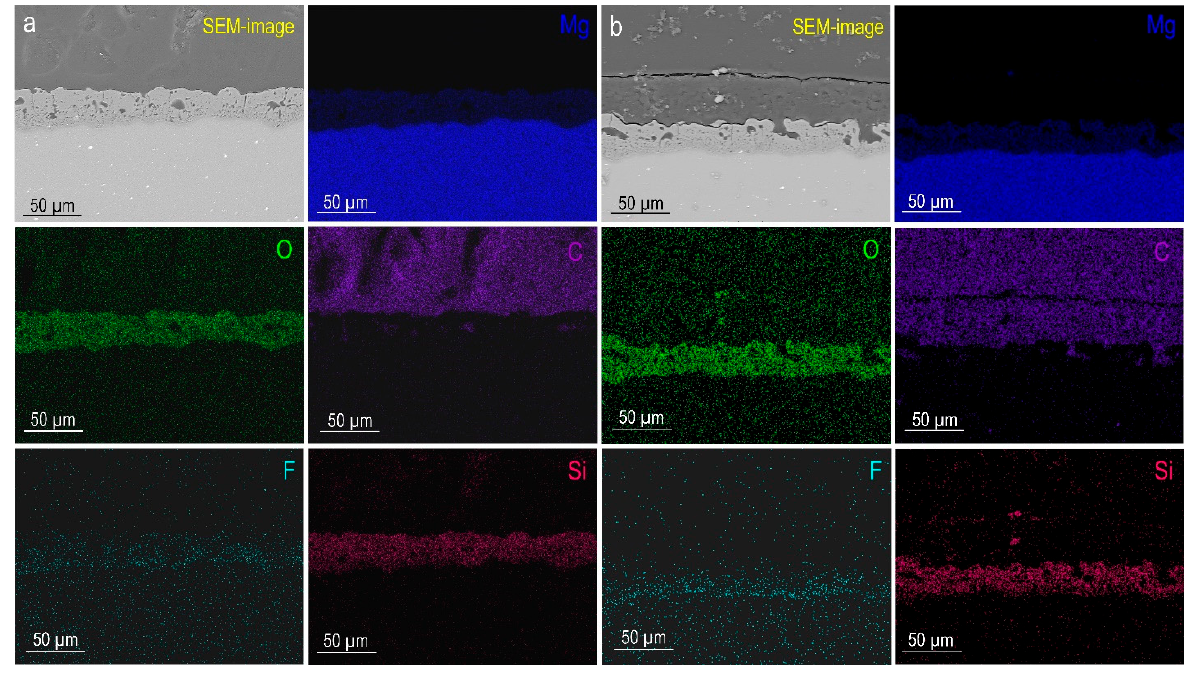
Figure 2. SEM images of cross-sections and EDX maps of elements’ distribution within the thickness of MA8 alloy sample with PEO coating ( a ) and CC-P coating ( b ).